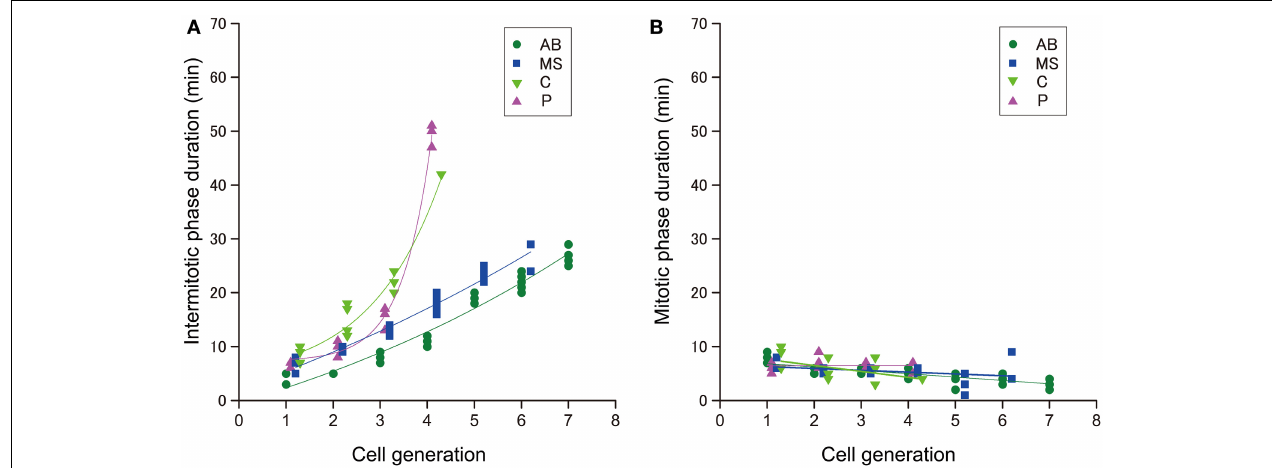
FIGURE 4 | The duration of cell cycle phases in C. elegans embryos. The duration of the (A) intermitotic phase or (B) mitotic phase in the size-correlated class; AB (green dot), MS (blue square), C (light green triangle), and P (magenta triangle) lineages are shown in linear plots in the